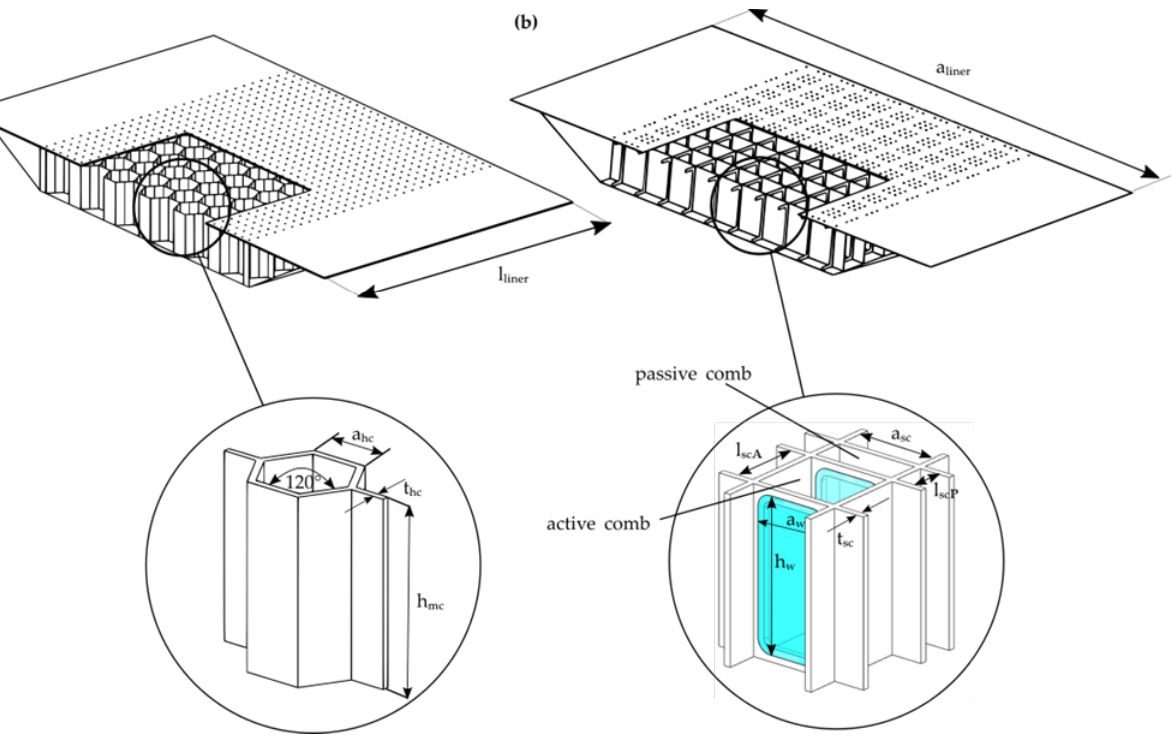
Figure 9. ( a ) Conventional HR liner and detailed honeycomb, ( b ) Resonator liner with square honeycombs detail of the square cells with film (turquoise ).